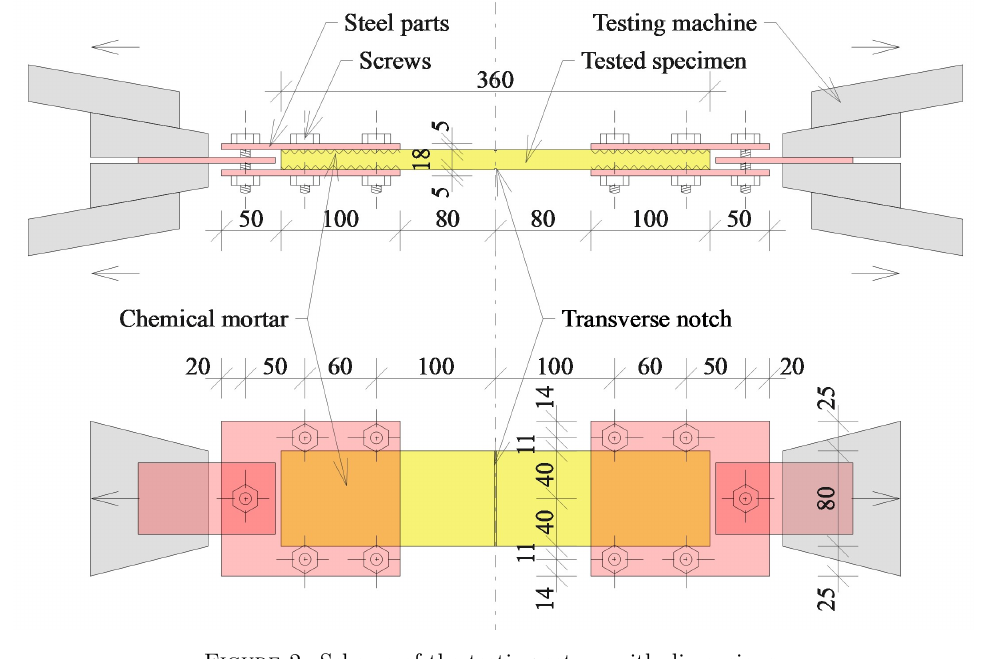
Figure 2. Scheme of the testing set up with dimensions.